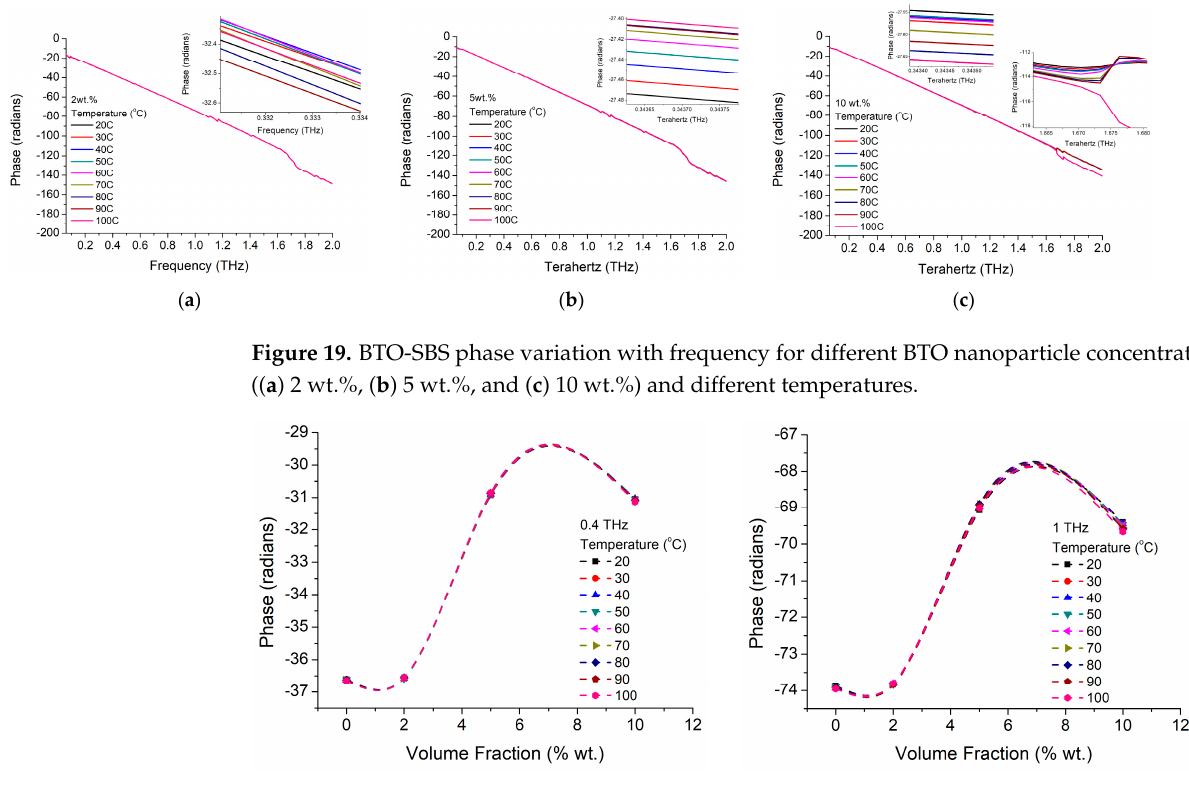
Figure 20. BTO-SBS phase variation with BTO nanoparticles volume fraction for two working frequencies of ( a ) 400 GHz and ( b ) 1 THz at different working temperature.